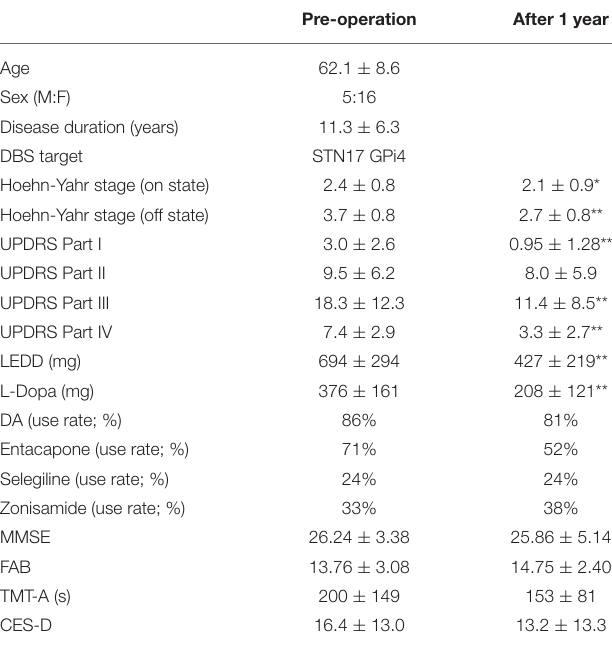
TABLE 1 | Patient